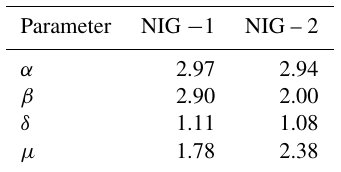
Table A1. Parameter values for climate sensitivity PDF composed of the product of two normal-inverse Gaussian (NIG) functions. An additional scaling parameter of 5.9047 is needed to make the inte- gral of the PDF